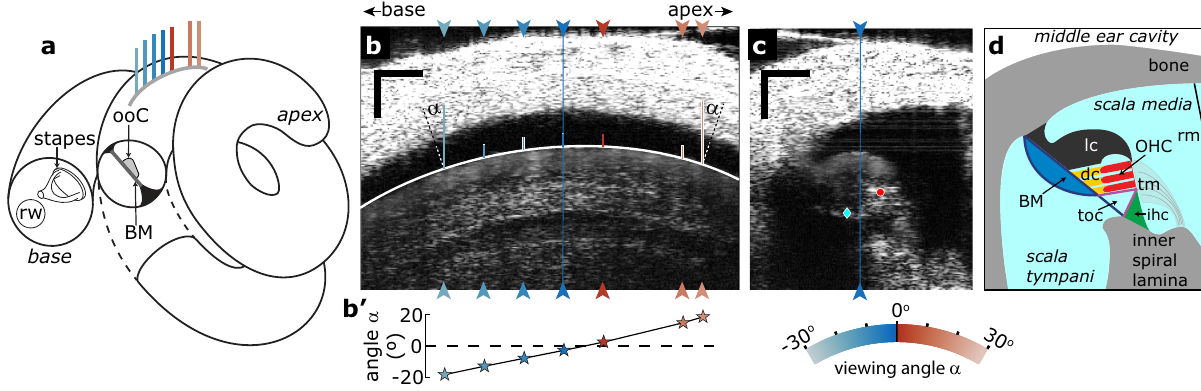
Fig. 1 Different viewing angles in the 2 nd turn of the cochlea. a Schematic diagram of the spiral gerbil cochlea with a cross-sectional plane (orthogonal to the longitudinal axis) in the 2 nd turn exposed to show the basilar membrane (BM) and the organ of Corti (ooC). The gray line represents the image location shown in b with colored lines indicating the different locations used for vibrometry. b Intensity image along the longitudinal axis in the 2 nd turn of the gerbil cochlea. Arrowheads indicate longitudinal locations at which cross-sectional images and vibrometry were recorded. Scale bars, 0.1 mm. Solid white line: ellipse fi tted to the boundary of the lateral compartment of the ooC. The angle between the normal of this ellipse and the vertical OCT beam at each longitudinal location at which a cross-sectional OCT image was acquired (arrow heads) served as an estimate for the “ viewing angle α ” between the OCT beam and the BM in the longitudinal direction. b ’ Viewing angles α of the OCT beam at the longitudinal locations indicated in b . These angles are color coded, see arched color legend below c . The same color coding is used throughout the manuscript. Scale bars, 0.1 mm. c Example cross-sectional intensity image, orthogonal to the longitudinal axis, obtained at the location indicated by the blue line in b . Sound-evoked vibrations were recorded from the BM (blue diamond) and within the OHC region (red circle). The blue line locates the intersection with the longitudinal plane. View into the paper is along the longitudinal axis, towards cochlear apex. Scale bars, 0.1 mm. d Schematic of the anatomical structures for the cross section shown in c . Fluid- fi lled spaces within the cochlea are light blue. BM basilar membrane, dc Deiter ’ s cells, ihc inner hair cell region, lc lateral compartment, OHC outer hair cell region, ooC organ of Corti, toc tunnel of Corti, rm Reissner ’ s membrane, rw round window, tm tectorial membrane. The blue-red colored arch encoded viewing angle, the same scale is used throughout the